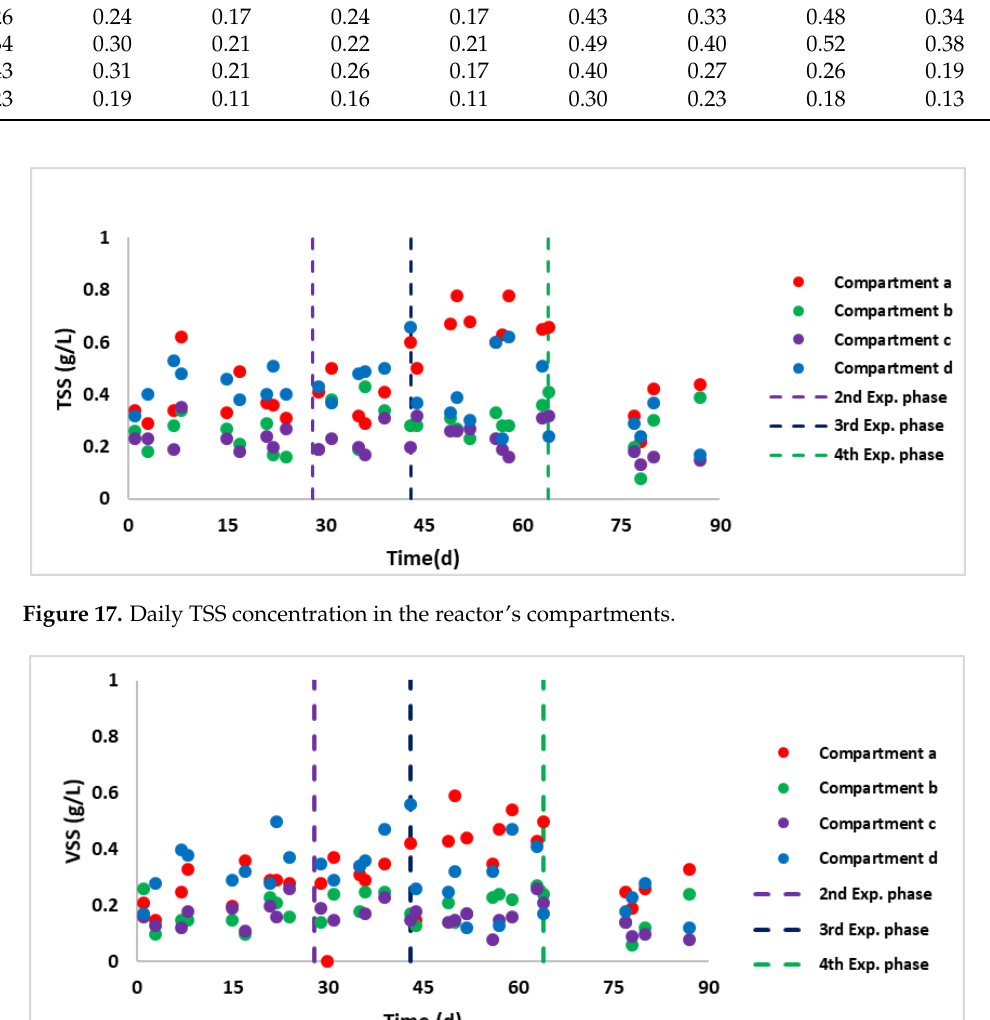
Figure 16 . Daily total alkalinity value of the feedstock and the reactor ’ s compartments. The average amount of TSS and VSS per compartment at every experimental phase Table 8. Average daily values of reactor’s compartment and effluent. is presented in Table 8, while their daily concentrations are presented in Figures 17 and 18, respectively. Table 8 . Average daily values of reactor ’ s compartment and effluent.